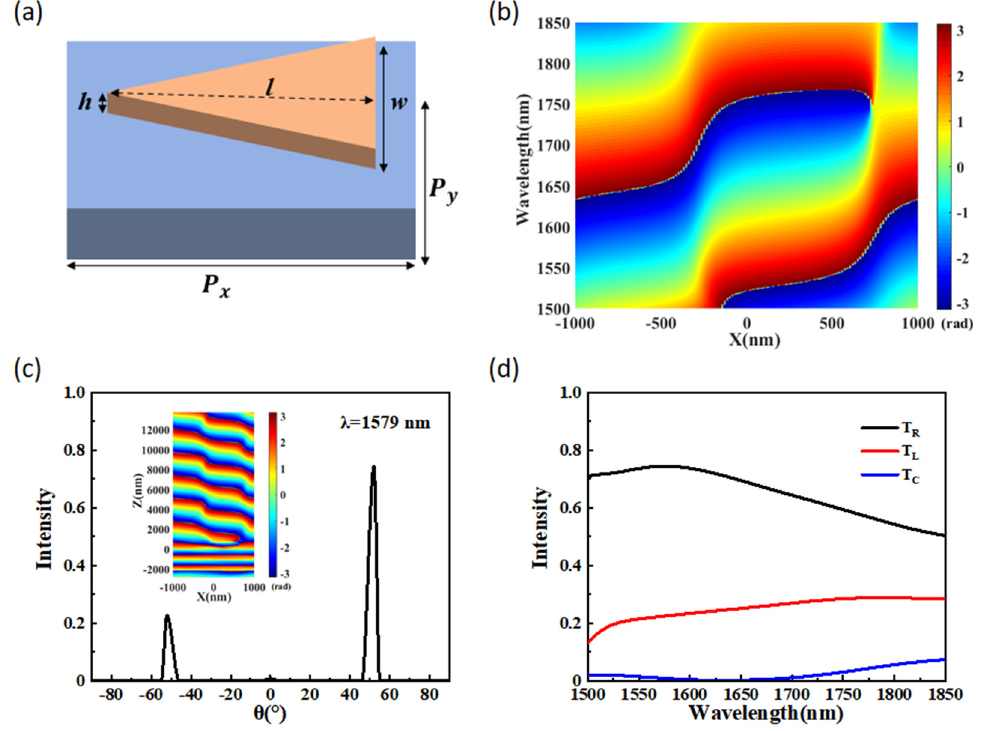
Figure 2. ( a ) Schematic of one unit cell of a simple metasurface with triangular GaP arrays on a quartz substrate. ( b ) The phase distribution along the x-direction of the unit cell within the 1500–1850 nm wavelength range. ( c ) Normalized far-field intensity distributions of the transmitted beams at a wavelength of 1579 nm, where the inset shows the phase distribution in the x-z plane. ( d ) Intensity of the anomalous transmission at 0, 1, and -1 diffraction orders.